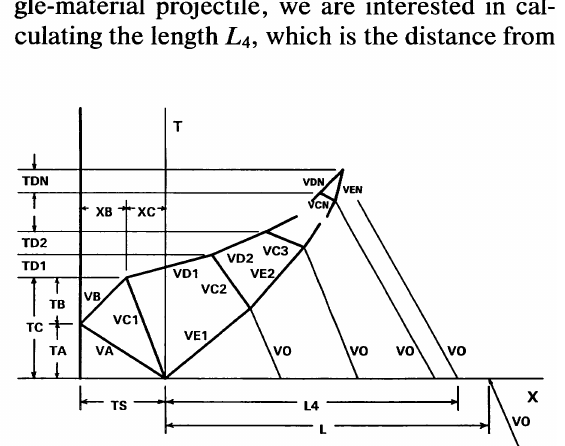
FIGURE 2 Extension of single-material X-T dia gram to multimaterial